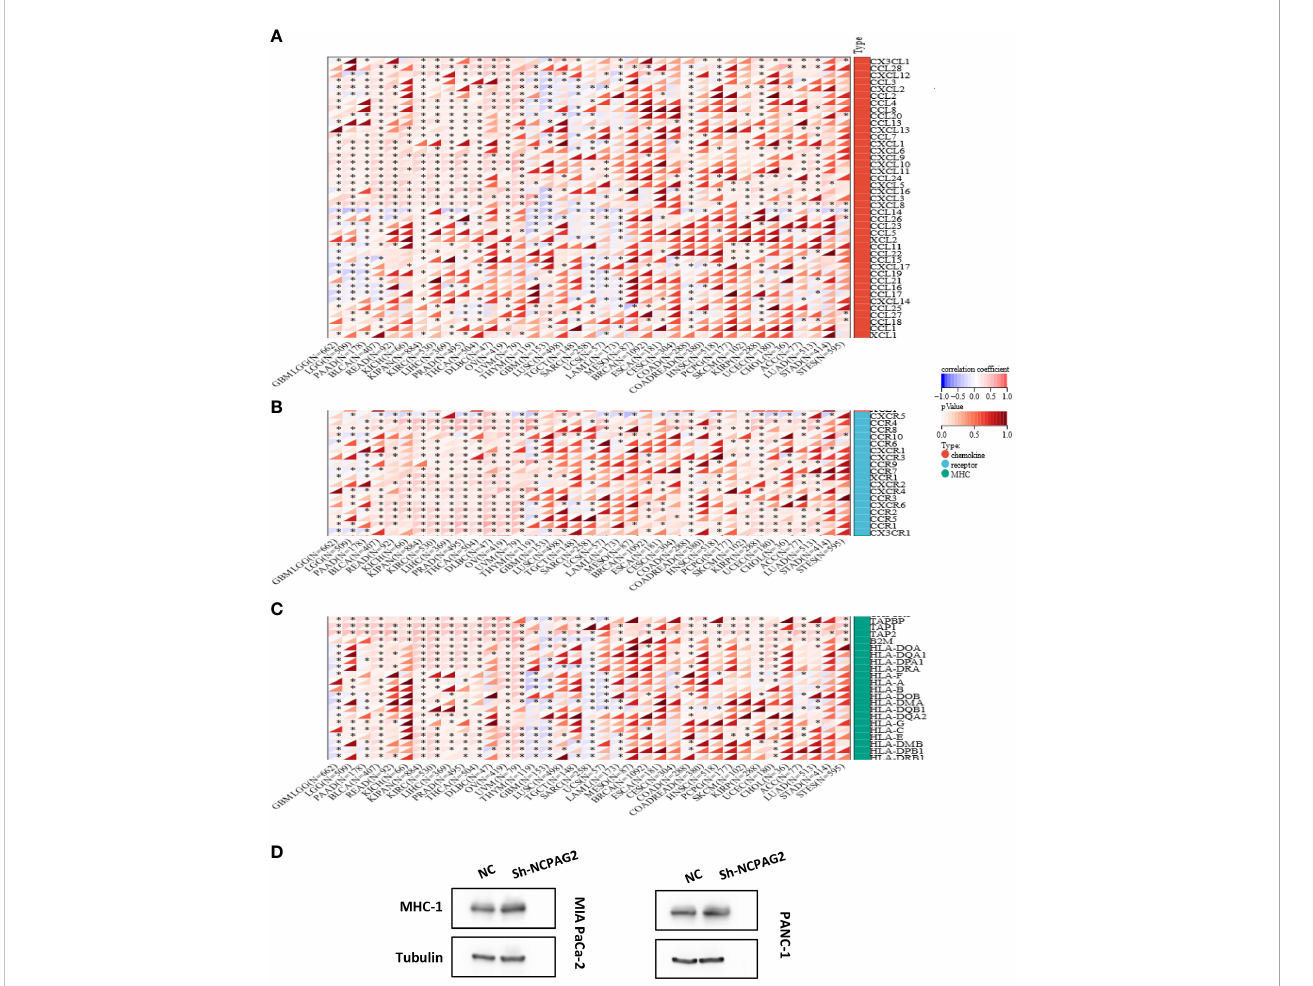
FIGURE 6 Correlation of NCAPG2 with the immunomodulatory genes. (A) NCAPG2 was closely related to the chemokine genes; (B) Correlation of NCAPG2 expression with chemokine receptor genes; (C) Correlation of NCAPG2 expression with MHC genes. *p<0.05; **p<0.01; ***p<0.001; (D) Expression differences of MHC-1 after NCAPG2